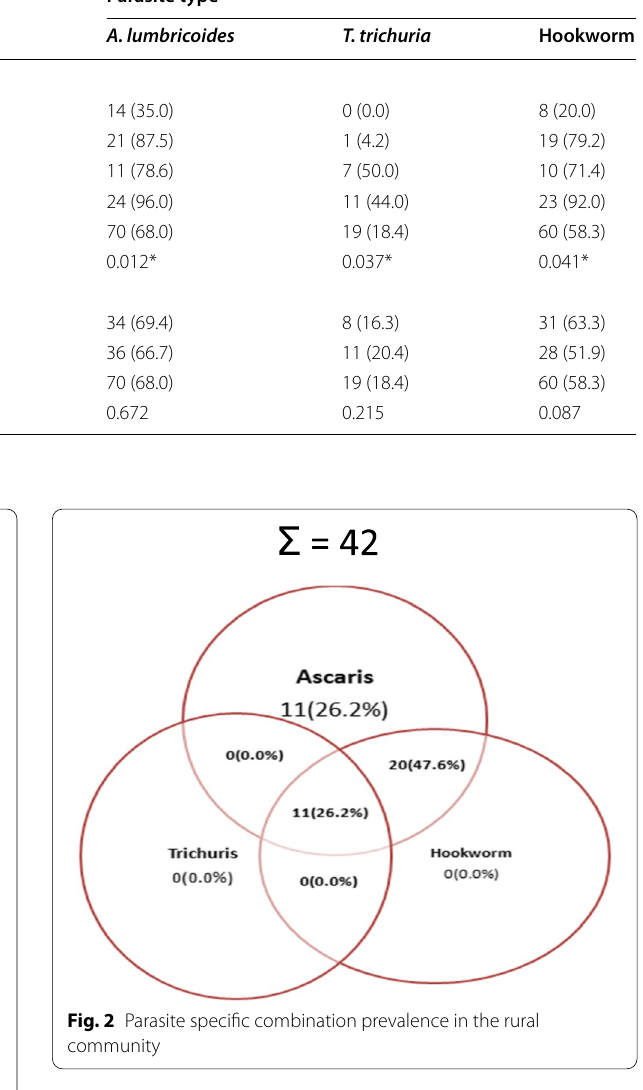
Table 4 Prevalence of STHs by age and gender across different parasite types Variables